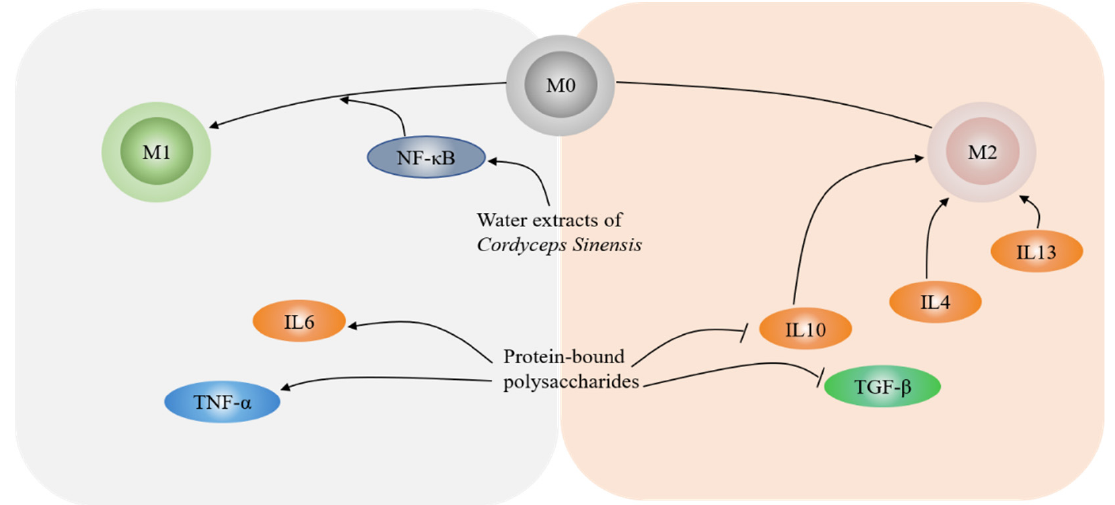
Figure 2. Antitumor mechanisms associated with regulation of macrophage polarization. The levels of IL-6 and TNF- α were elevated and the expression of IL-10 and TGF- β was decreased in protein-bound polysaccharides (PBP) cultured breast cancer cells. PBP regulates M1/M2 polarization and exhibits antitumor activities during breast cancer progression. Water extracts of Cordyceps sinensis exert anti-breast cancer effects by regulating the differentiation of macrophages to M1-like macrophages through modulation of NF- κ B signaling pathway.